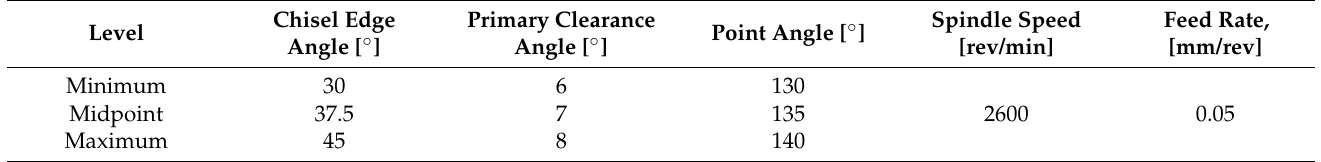
Table 2. Experimental factors at different levels of chisel edge angle (A), primary clearance angle (B), and point angle (C).